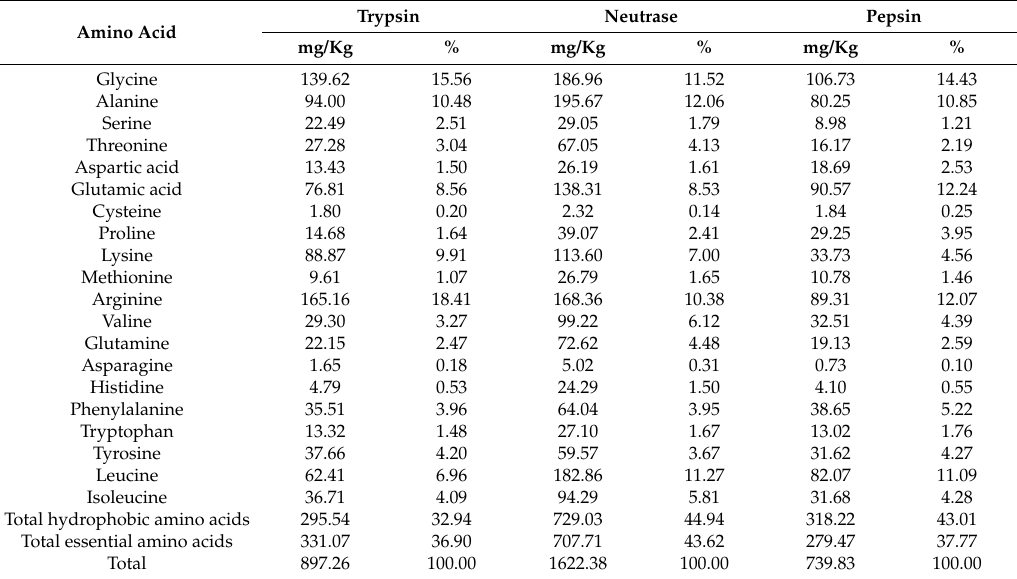
Table 2. Free amino acid compositions of hydrolysates from R. philippinarum proteins. Amino